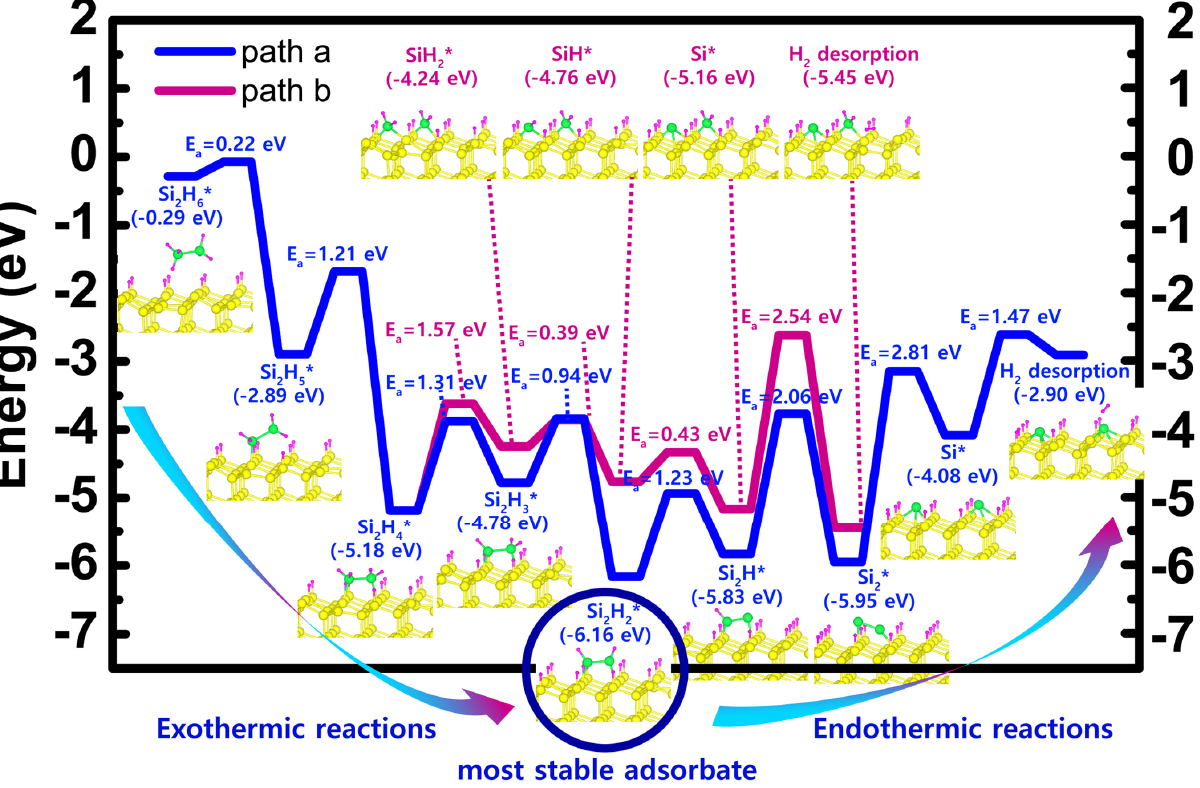
Figure 9. Calculated overall energy diagram of Si 2 H 6 dissociative reactions for path a and b on the H-50% covered Si(111) surface.